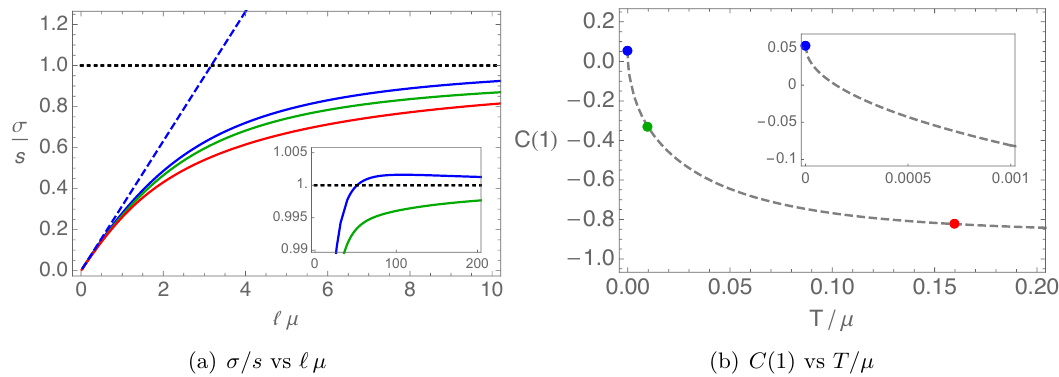
Figure 3 . Entanglement density of the normal phase. Left: σ/s (solid lines) at T/µ = (0 . 16 , 0 . 01 , 0) (red, green, blue). Black dotted line is a guide line for σ/s = 1 and the blue dashed line is (3.14). The inset shows the large ‘ µ behavior. Right: C (1) (dashed line). Dots correspond to data used in figure 3(a). The inset shows the low T/µ behavior: C (1) > 0 at low T